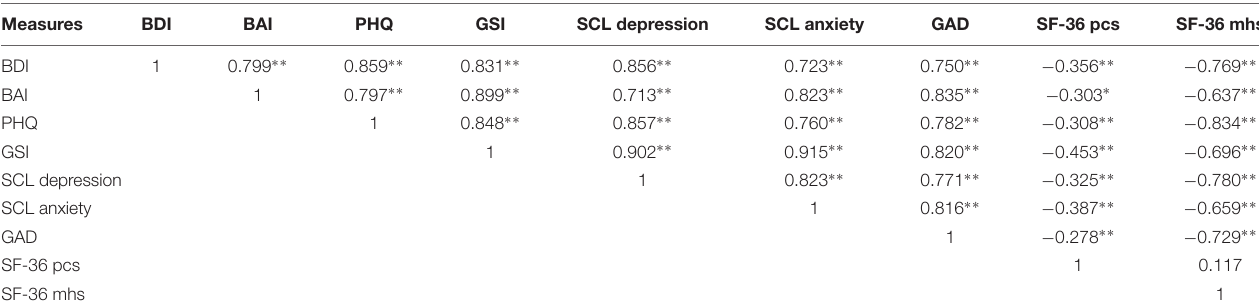
TABLE 3 | Correlation between measures at